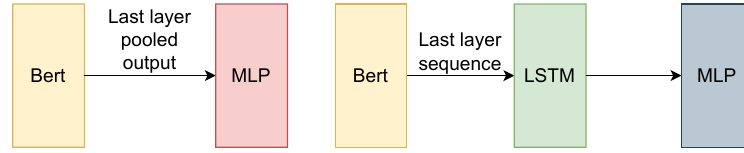
Figure 7. Simple BERT usages.